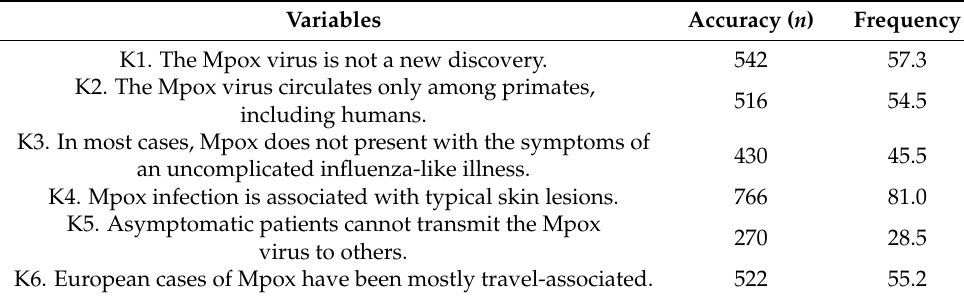
Table 2. General characteristics of